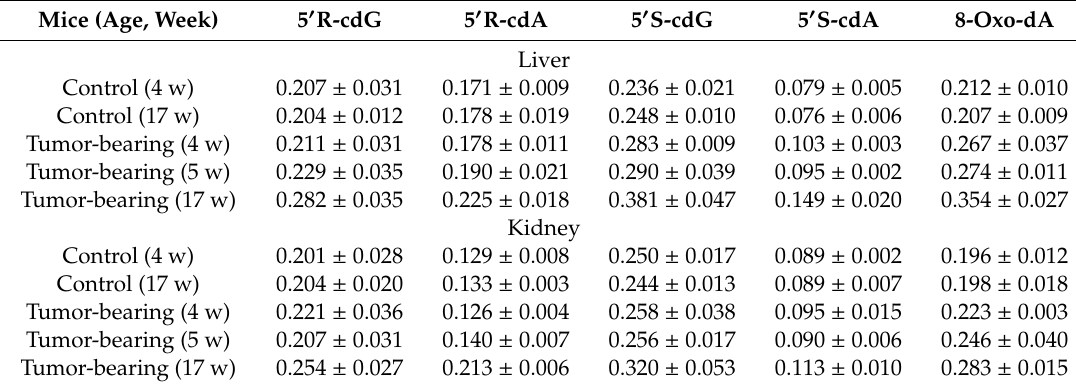
Table 1. The levels (lesions / 10 6 nucleosides) of 5 (cid:48) S -cdA, 5 (cid:48) R -cdA, 5 (cid:48) S -cdG, 5 (cid:48) R -cdG and 8-oxo-dA in genomic DNA of liver and kidney of control SCID mice and tumor-bearing SCID mice in each age point. The numbers in the boxes represent the mean value ( ± standard deviation) of cPu and 8-oxo-dA levels from the measurement of three DNA samples isolated from three independent animals of each tissue. w: week.